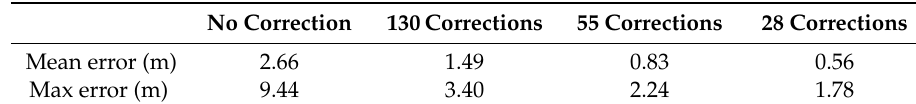
Table 3. Trajectory with different step thresholds.